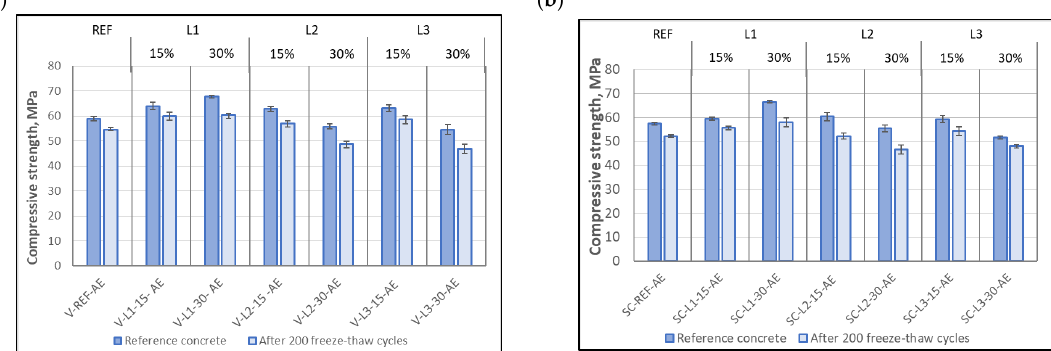
Figure 14. Compressive strength of ( a ) vibrated concrete and ( b ) self-compacting concrete, both with air-entraining admixture.